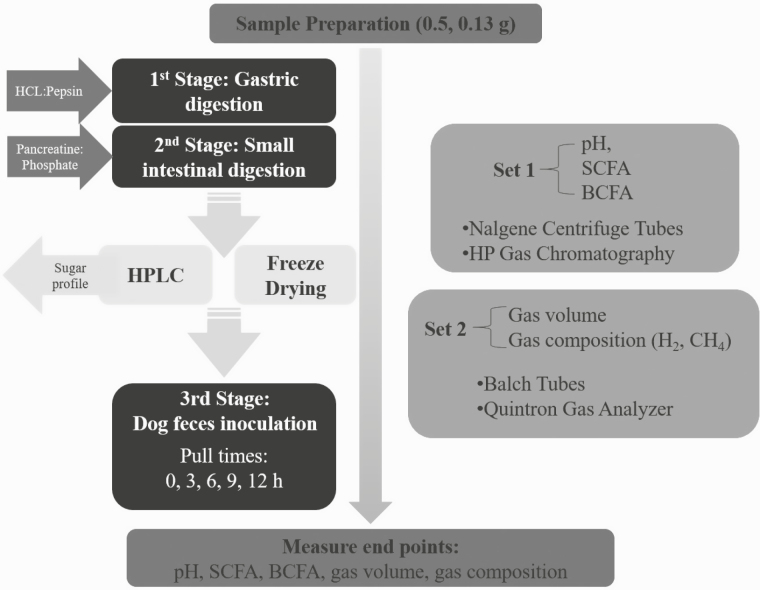
In vitro fermentation procedure based on methods of Bourquin et al. (1993). Two sets of fermentations were conducted in triplicate for each sample. Sample aliquots (0.5 g for Set 1 and 0.13 g for Set 2) were first digested for 6 h with a phosphate-buffered HCL and pepsin solution (pH ~2), followed by a phosphate buffered pancreatin for 18 h. Free sugar profiles were analyzed and representative sugar blanks were developed and digested samples were lyophilized. Fecal bacteria for inoculation were composited from freshly voided samples of three female beagles and added to medium as described by Bourquin et al. (1993). Freeze-dried samples were inoculated with canine fecal bacteria, flushed with CO2, and incubated at 39°C for 0, 3, 6, 9, or 12 h and immediately submerged in an ice bath to abruptly stop the fermentation process. Samples then were analyzed for pH, and subsequently analyzed for SCFA and BCFA (Set 1), and gas volume and composition (Set 2).